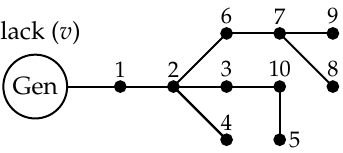
Figure 4. Electrical configuration for the 10-bus test feeder [11].